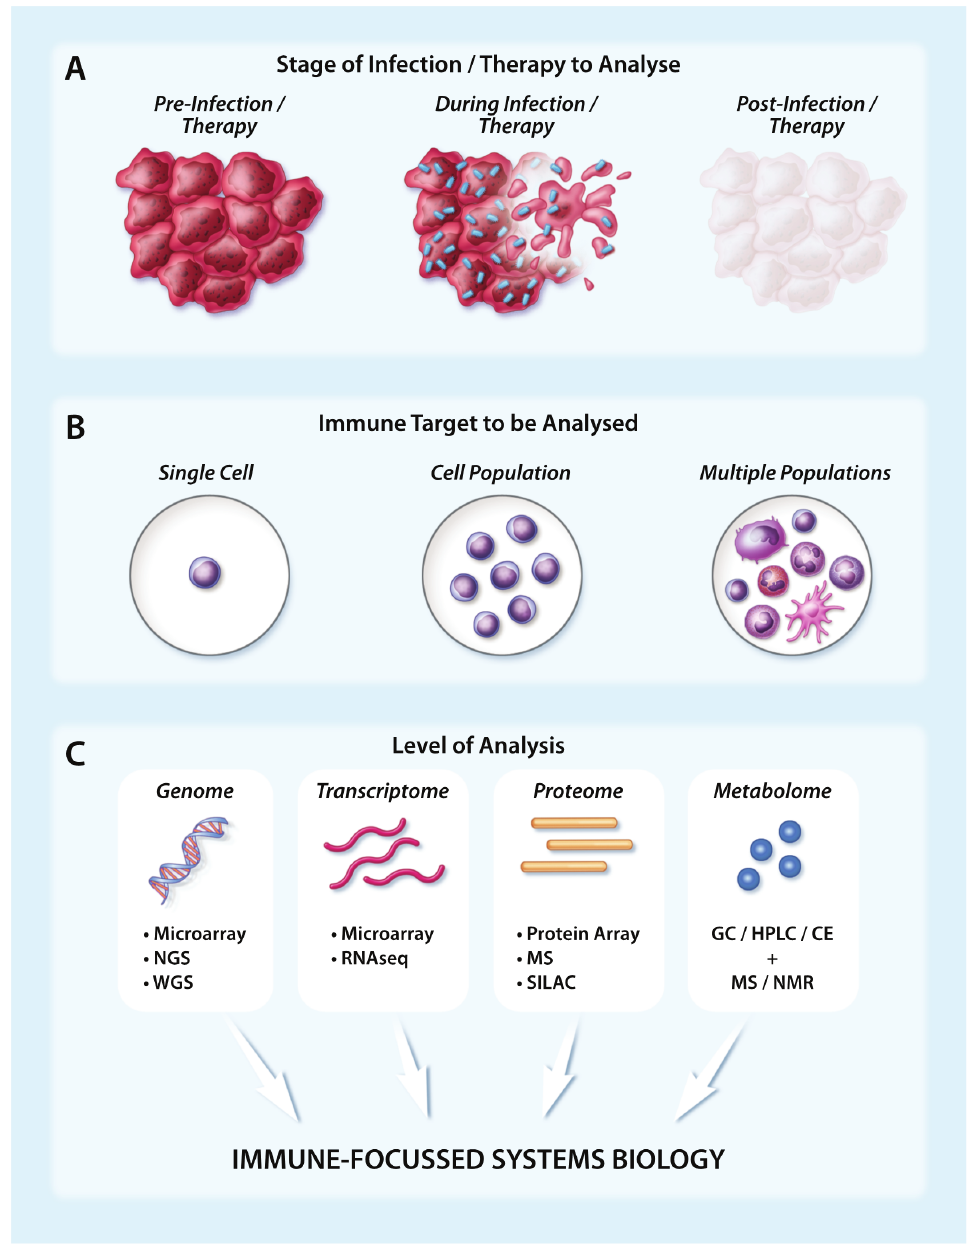
Figure 1. Analysing immune targets using large-scale technologies in the tumour setting following infection/therapy. ( A ) The immune response to infection or immunotherapy in the tumour setting can be captured at multiple different timepoints, including prior to infection/therapy (left), during infection/therapy as cancer cells begin to die (middle), and following infection/therapy when the tumour has been ablated or reduced in bulkiness (right); ( B ) Large-scale immune analysis can be performed at the level of a single immune cell, an immune cell population or multiple immune cell populations; ( C ) Several key large-scale techniques can capture genomic, transcriptomic, proteomic or metabolomic changes at the immune level. When assays have been appropriately replicated and validated, matched data generated at the DNA, RNA and protein level can subsequently be integrated to achieve a systems biology approach. Abbreviations: CE = Capillary Electrophoresis, GC = Gas Chromatography, HPLC = High Performance Liquid Chromatography, MS = Mass Spectrometry, NGS = Next-Generation Sequencing, NMR = Nuclear Magnetic Resonance, RNASeq = RNA Sequencing, SILAC = stable isotope labelling by amino acids in cell culture, WGS = Whole Genome Sequencing.